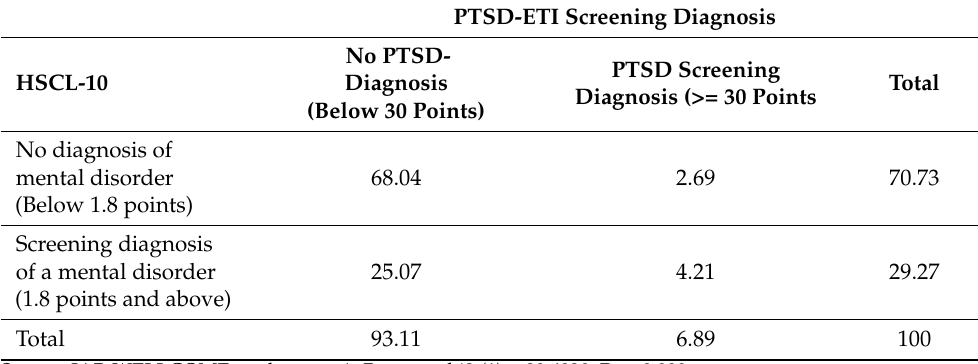
Figure 2. Full-time employment rate by PTSD-ETI and HSCL-10 scores (percentiles) in 2021. Source: IAB-WELLCOME study wave 1; IEB, V16.01.